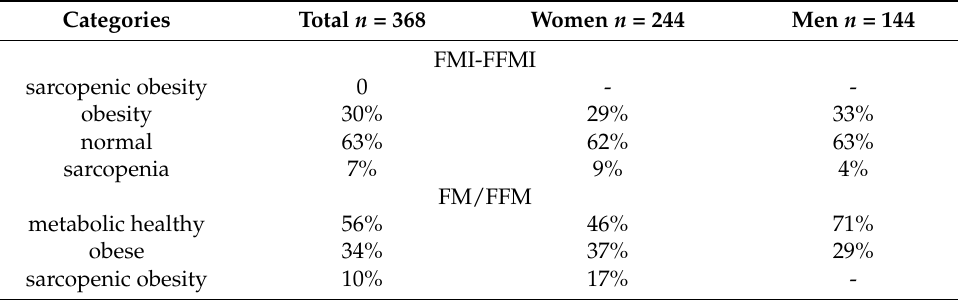
Table 2. Distribution of study participants by FM and FFM classification.